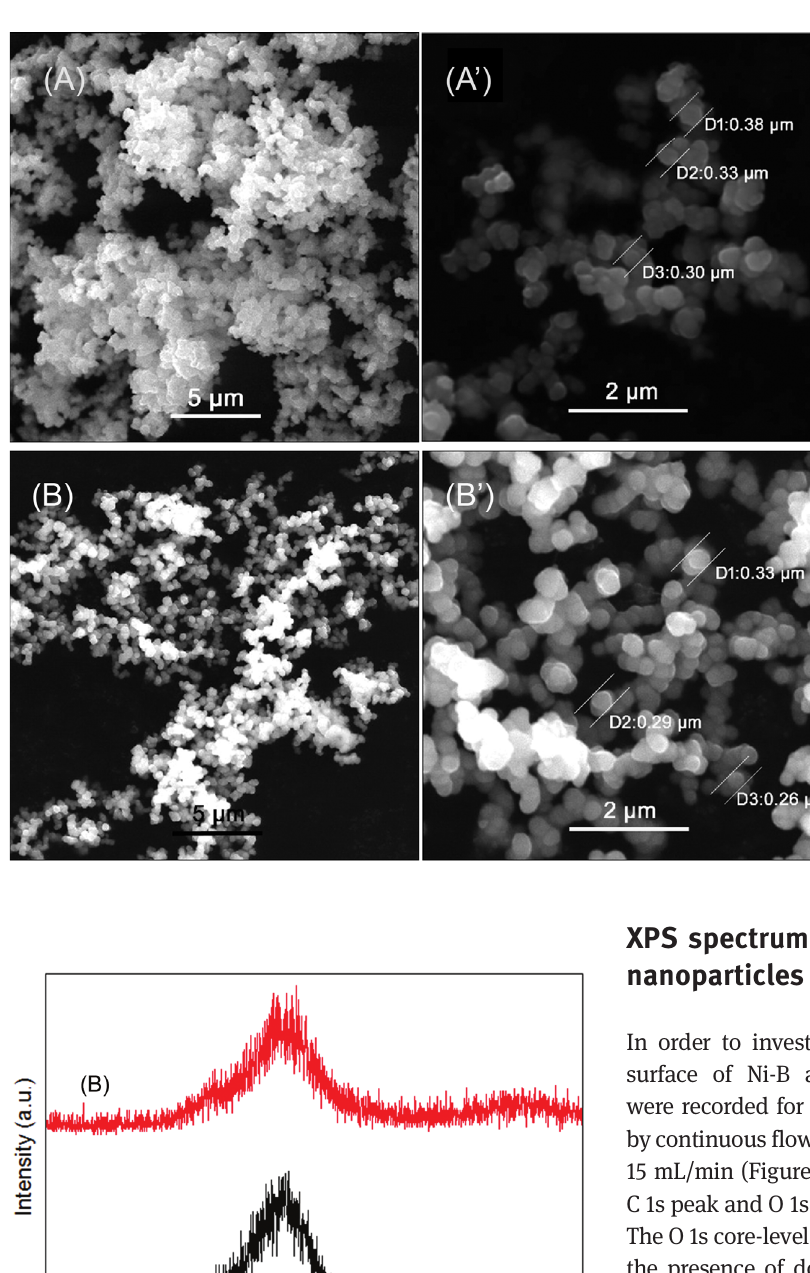
Figure 4: XRD patterns of Ni-B amorphous nanoparticles prepared by continuous flow in microfluidic reactor at the flow rates of 15 mL/min (A) and 25 mL/min (B).